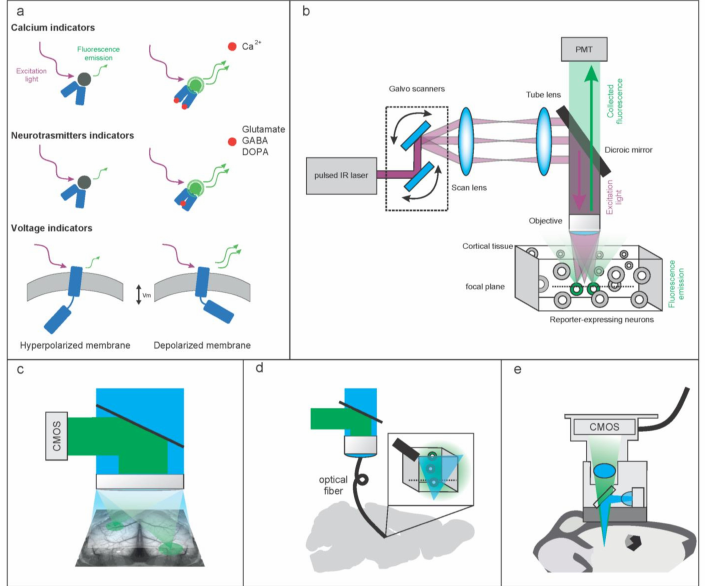
Figure 1. Fluorescence-based methods for in vivo imaging of neuronal physiology. ( a ) Genetically encoded fluorescent reporters of calcium (top), neurotransmitters (middle) and membrane potential (bottom) are designed to display variations in the fluorescence yield (green) as a consequence of the binding of the analyte to the reporter or changes in the electrical potential across cell’s membrane. ( b ) Generic scheme of scanning fluorescence microscope: excitation light (purple, infrared in the case of two-photon laser source) enters the sample through an optical access and is confined in a diffraction limited spot in the tissue expressing the genetically-encoded reporter (circles representing neuronal cells). The excitation beam is scanned across the tissue using a pair of galvanometric mirrors (or equivalent devices such as resonant scanners or acousto-optical deflectors) pointing sequentially the diffraction limited spot to fixed coordinates in a raster. Fluorescence from cells expressing the reporter (green) is collected as it irradiates outside the tissue, as the excitation beam stops at each position in the scanning sequence. An image is then reconstructed using a bucket detector (e.g., photomultiplier tube). This scheme applies to two-photon imaging of deep structures. ( c ) In the case of wide-field imaging, the excitation light homogeneously illuminates the tissue and the fluorescence is collected with a spatially-resolved sensor. ( d ) In fiber photometry approaches, fluorescence is excited in the proximity of a penetrating optical probe (fiber) inserted in the tissue. The excitation light exits the tip of the probe and the local fluorescence intensity is recorded through the same optical fiber without forming an image. ( e ) Miniscopes are miniaturized fluorescence microscopes designed to be implanted on the animal’s skull, allowing for recordings during unrestrained behavior. Excitation light is delivered inside the tissue through an optical fiber or an optical access to the dorsal brain surface. The fluorescence is collected by a spatially resolved sensor in order to form an image. All these methods are capable of recording data sequentially, allowing for a dynamic (i.e., extended in time) characterization of neuronal